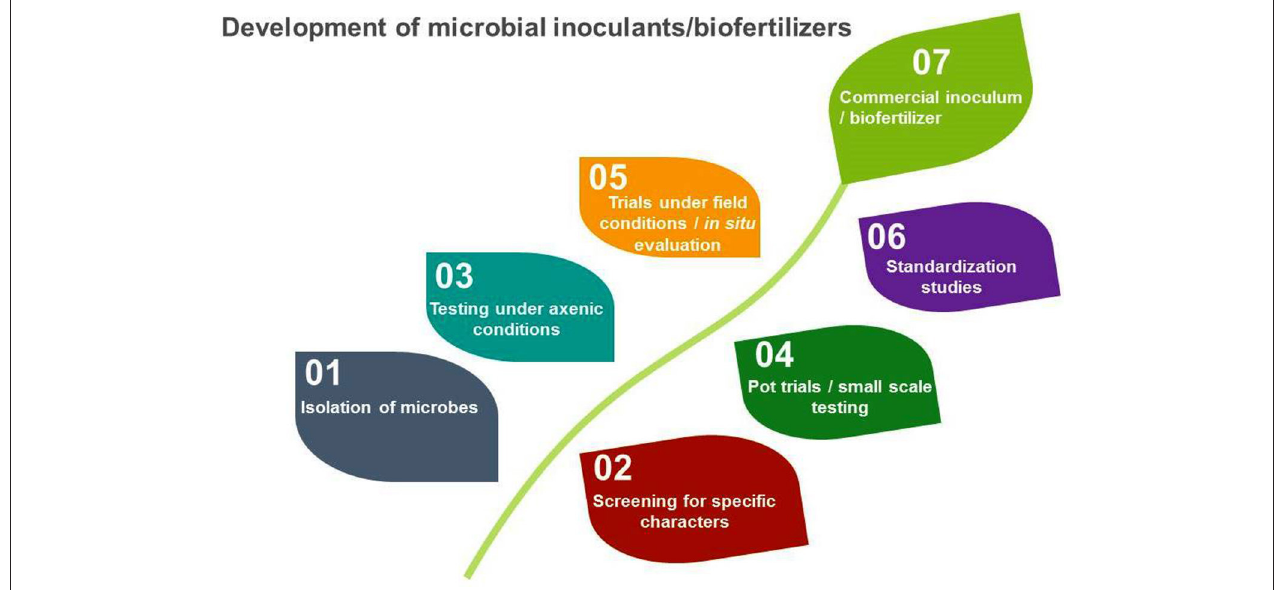
FIGURE 1 | Stages in the development and commercialization of microbial inoculants/biofertilizers.